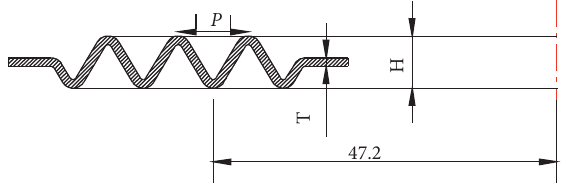
Figure 17: Gasket size.